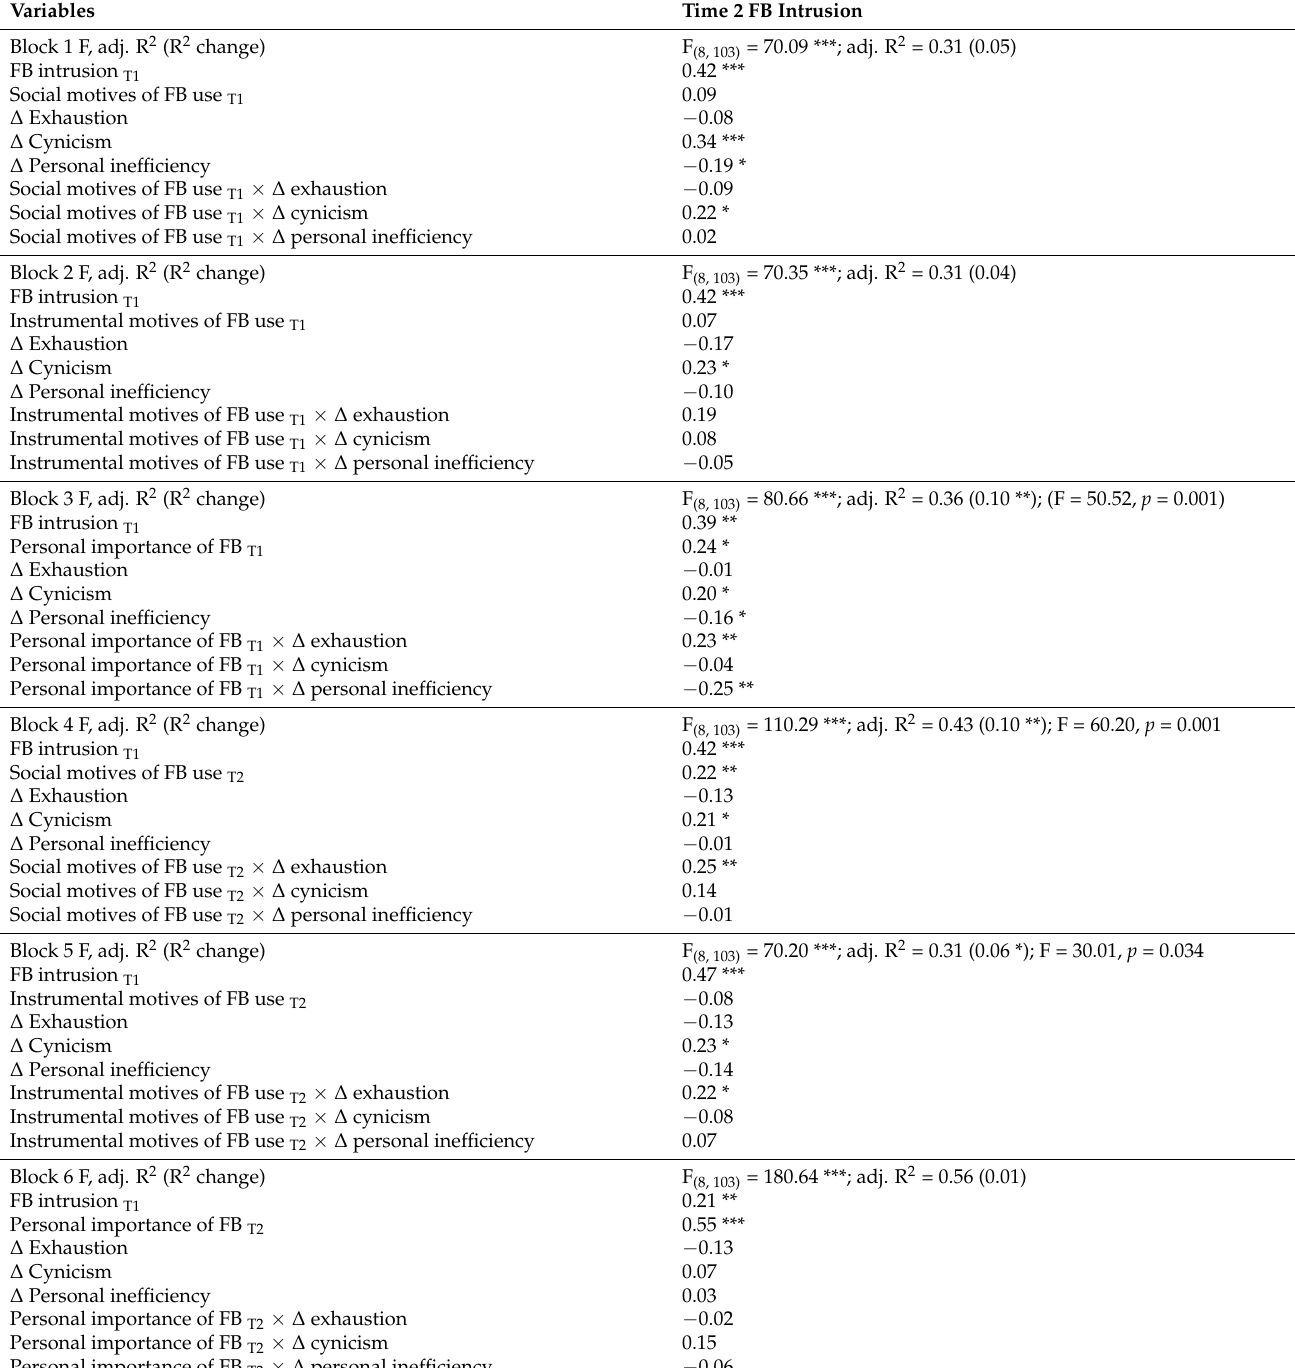
Table 3. Results of hierarchical regression analyses examining the effects of changes in academic burnout dimensions and FB motives and importance measured at times 1 and 2 on the FB intrusion measured at time